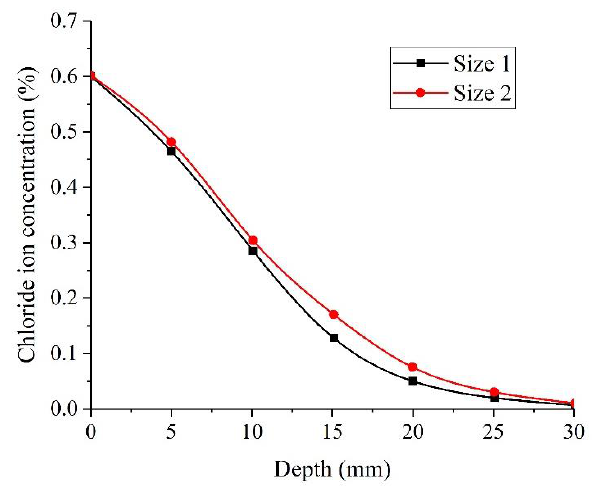
Figure 19. Chloride ion concentration of specimen HPC50 with different aggregate size.